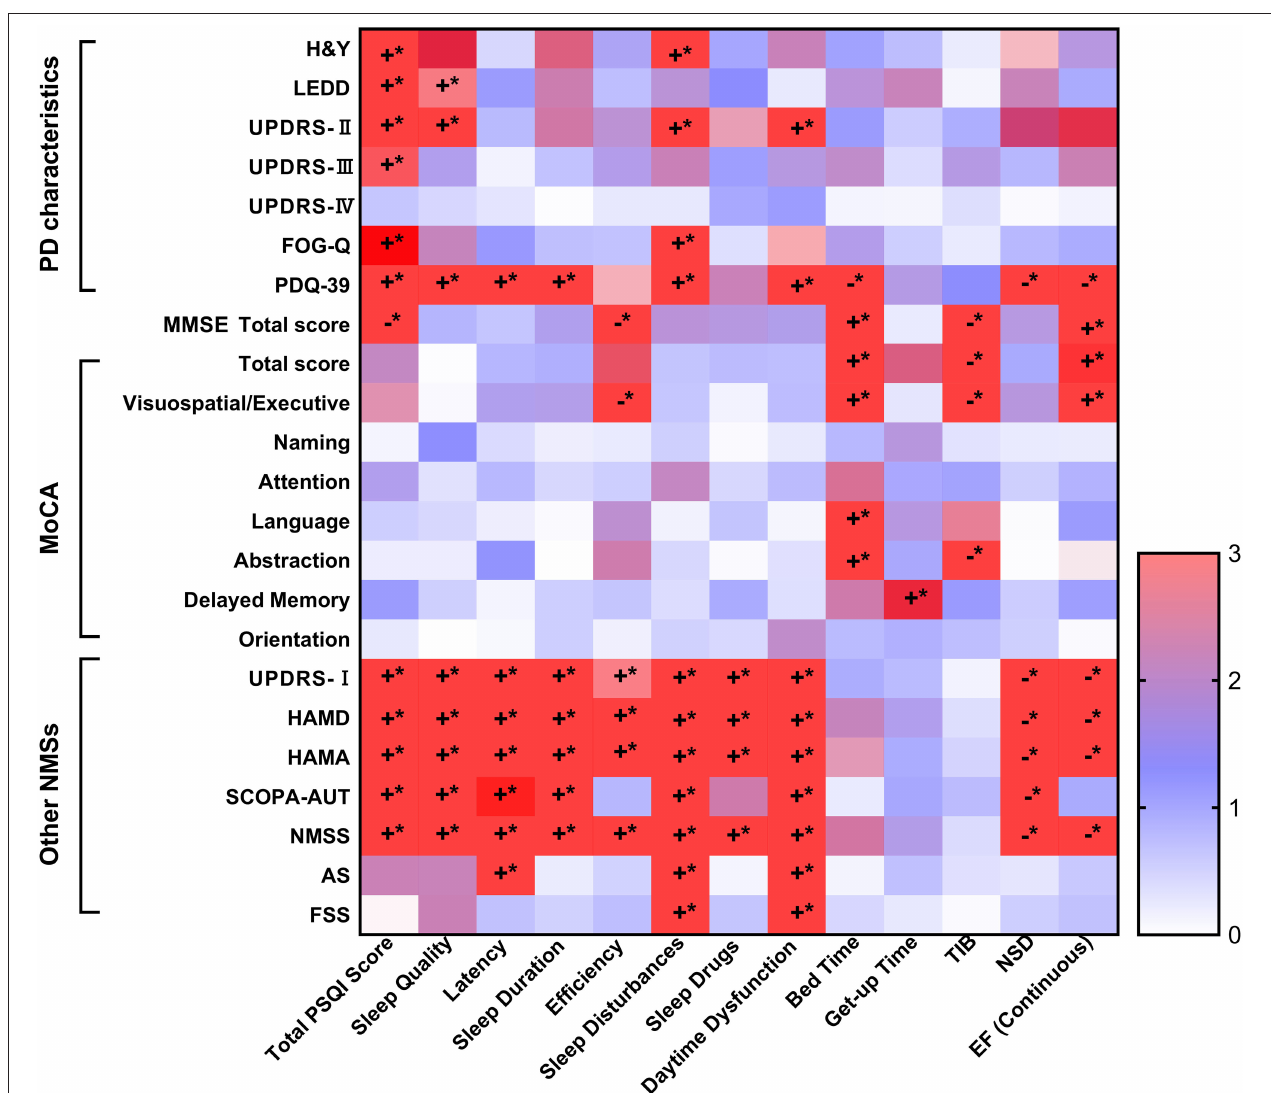
FIGURE 1 | The Spearman’s correlations of PSQI and PD symptoms. The sleep characteristics and habits showed significant associations with PD characteristics, as well as motor and NMSs. Specifically, the increasing total PSQI scores were related to more severe PD characteristics, including higher scores of H&Y stages, UPDRS-II and III, FOG-Q and PDQ-39, as well as higher doses of LEDD. Poorer sleep levels were also associated to worse cognitive function, though only total MMSE score, orientation, and language and praxis survived after Bonferroni correction ( p < 0.002). Further, it was illustrated that elevated total PSQI scores correlated with more serious NMSs covered NMS burden, depression, anxiety, autonomic dysfunction, apathy, and fatigue ( p < 0.05). * The p -value was survived after Bonferroni correction ( p < 0.002). AS , Apathy Scale; EF , efficiency; FOG-Q , Freezing of Gait Questionnaire; FSS , Fatigue Severity Scale; HAMA , Hamilton Anxiety Rating Scale; HAMD , Hamilton Depression Rating Scale; H&Y, Hoehn-Yahr stage; LEDD , levodopa equivalent daily dose; MDS-UPDRS , Movement Disorder Society Unified Parkinson’s Disease Rating Scale; MMSE , Mini-Mental State Examination; MoCA , Montreal Cognitive Assessment; NMSS , Non-Motor Symptoms Scales; NSD , nocturnal sleep duration; PD , Parkinson’s disease; PDQ-39 , 39-item Parkinson’s Disease Questionnaire; PSQI , Pittsburgh Sleep Quality Index; SCOPA-AUT , Scale for Outcomes in PD for Autonomic Symptoms, TIB , total time spent in bed. The “ + ” was symbolized to positive correlated, while the “ − ” was negative correlated. The “*” was on behalf of statistically significant difference ( p <